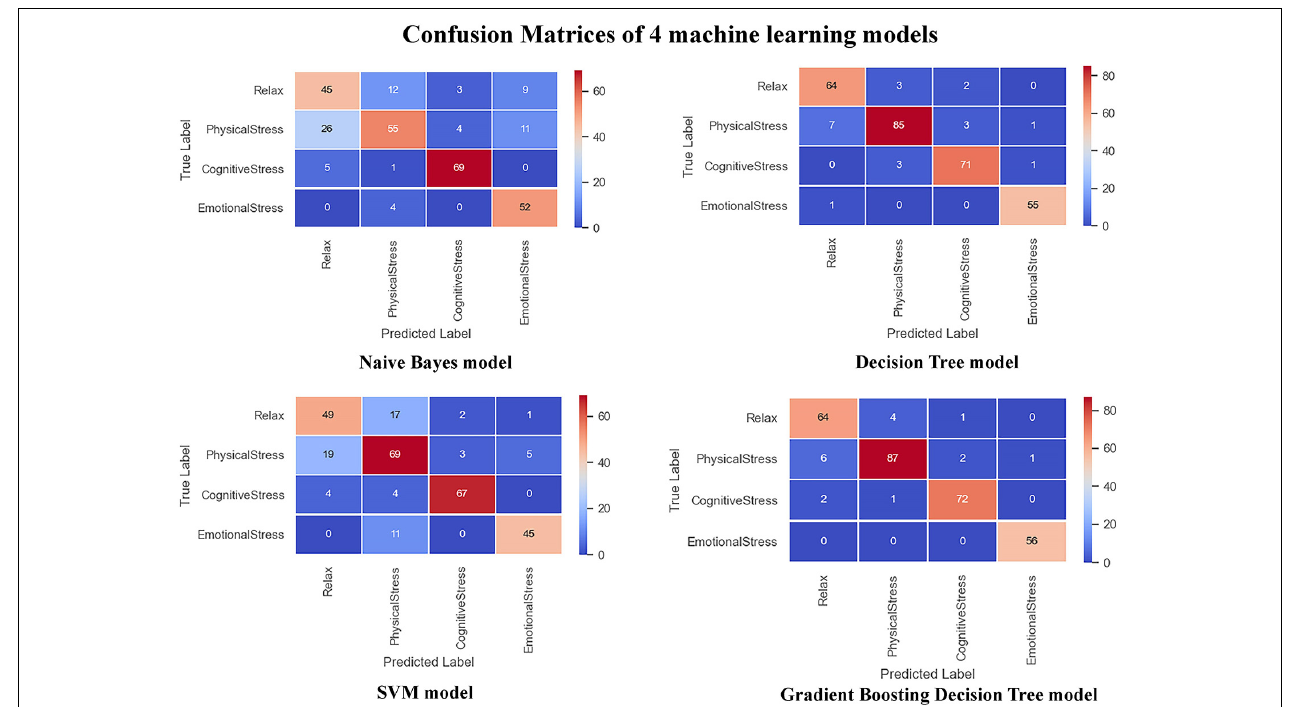
FIGURE 9 | Confusion matrices of test